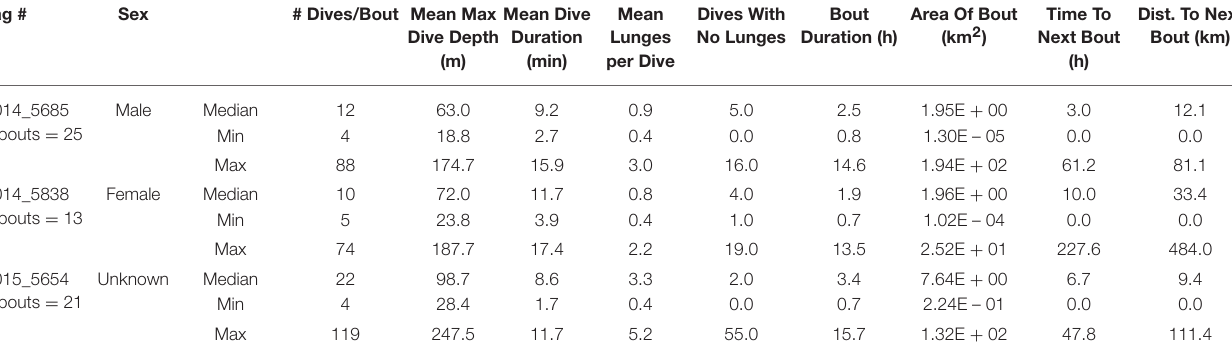
TABLE 3 | Summary of dives occurring during feeding bouts made by three fin whales instrumented with ADB tags off southern California in August 2014 and July 2015. Tag # Sex Mean